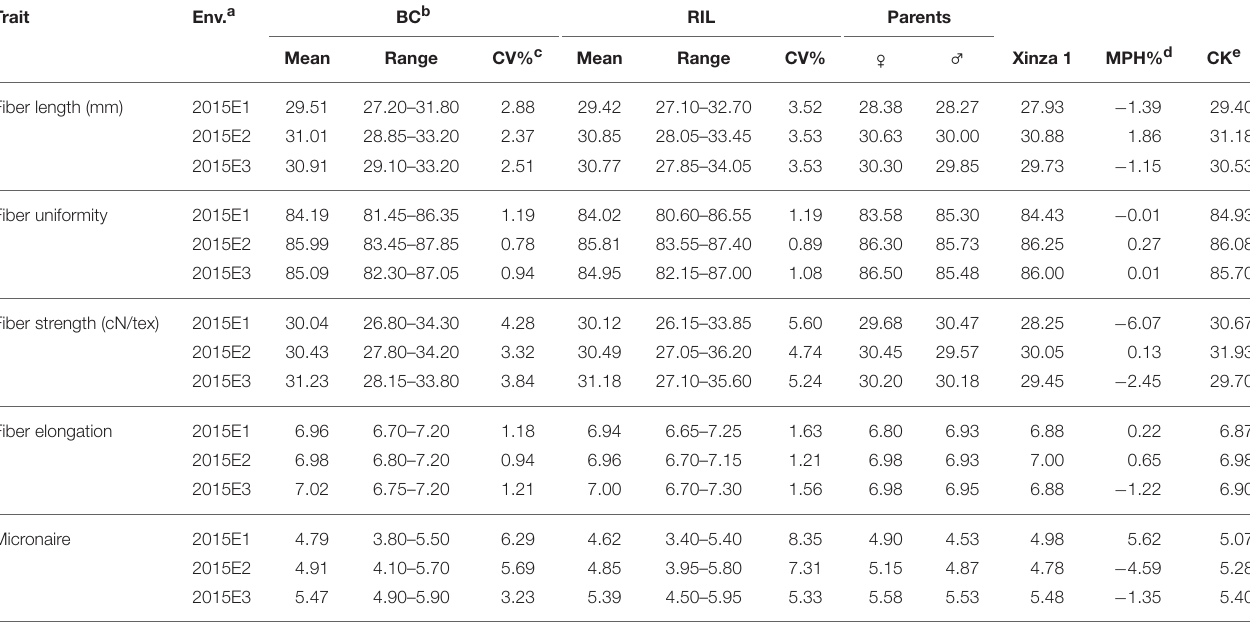
TABLE 1 | Summary statistics on fiber quality trait data of RIL and BC populations in three environments. Trait Env.